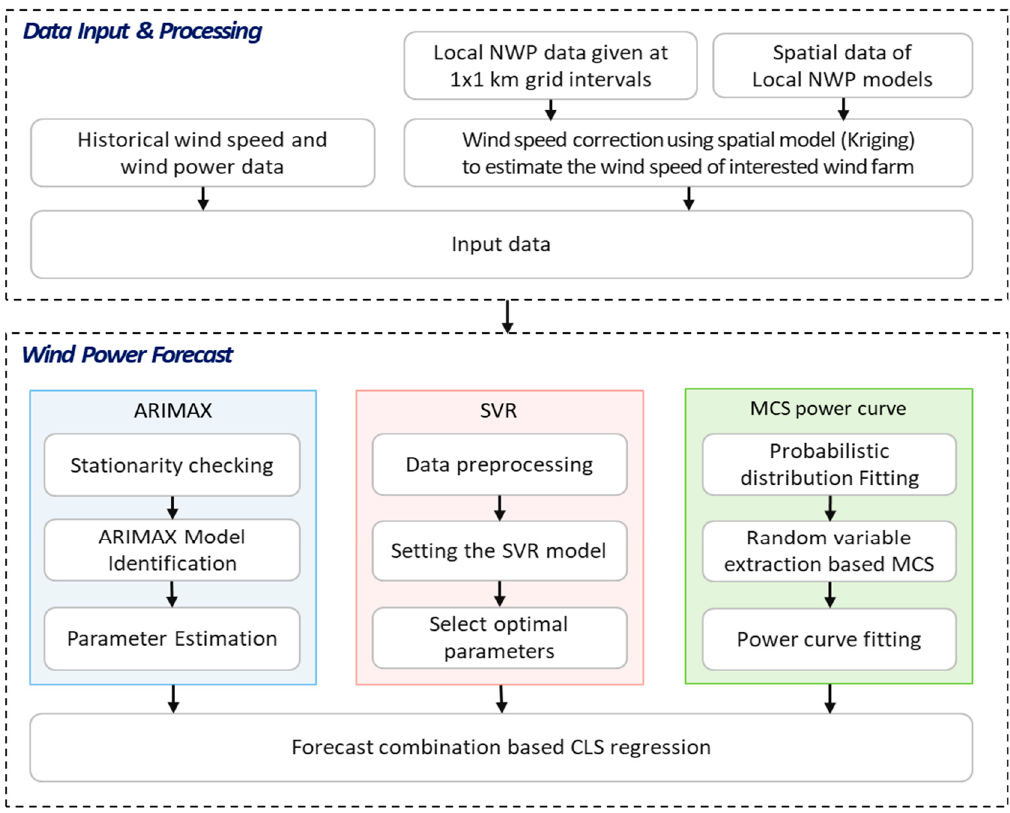
Figure 1 . The proposed algorithm for wind power forecasting. Figure 1. The proposed algorithm for wind power forecasting.